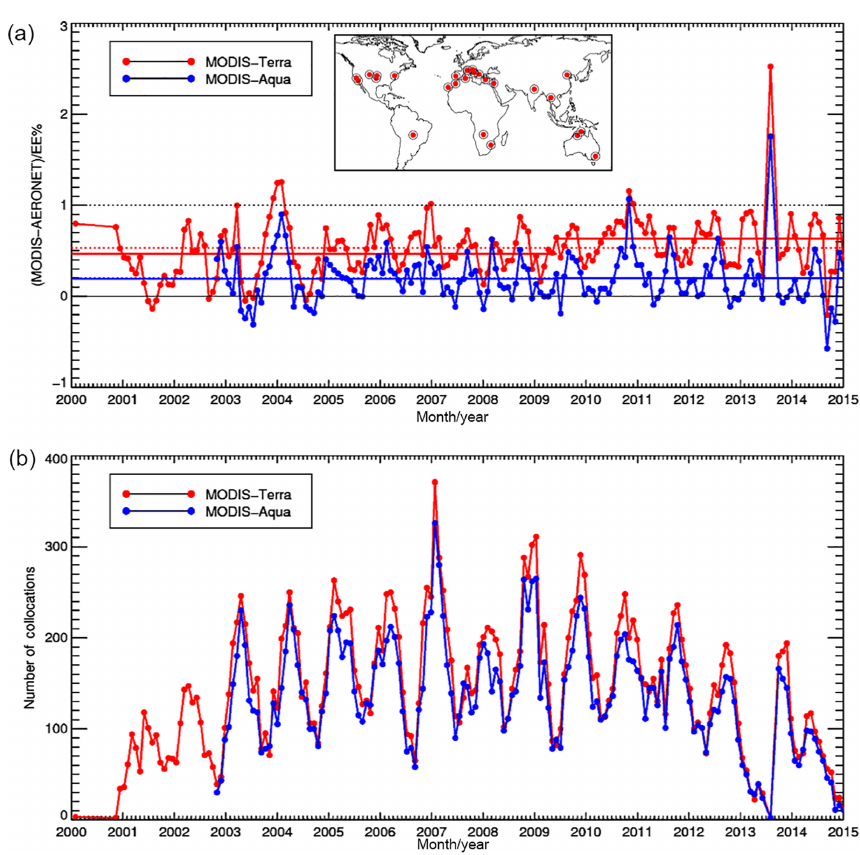
Figure 9. Time series of monthly mean error ratios (Eq. 3) (a) and number of collocations (b) for the global collocation data set from 26 selected long-term AERONET stations. The Terra record is in red, and Aqua in blue. Note that Aqua’s record begins 2 years after Terra, and the total number of collocations is temporally variant. Only MODIS 3km retrievals with QAF = 3 are included. The horizontal red and blue lines are temporal means of ER. Dotted red and blue horizontal lines indicate long-term temporal mean ER for each satellite. Solid red lines are temporal mean ER calculated for Terra for two periods (2000–2010) and (2011–2015). The map in the inset shows locations of AERONET stations used in this analysis with more details provided in Table